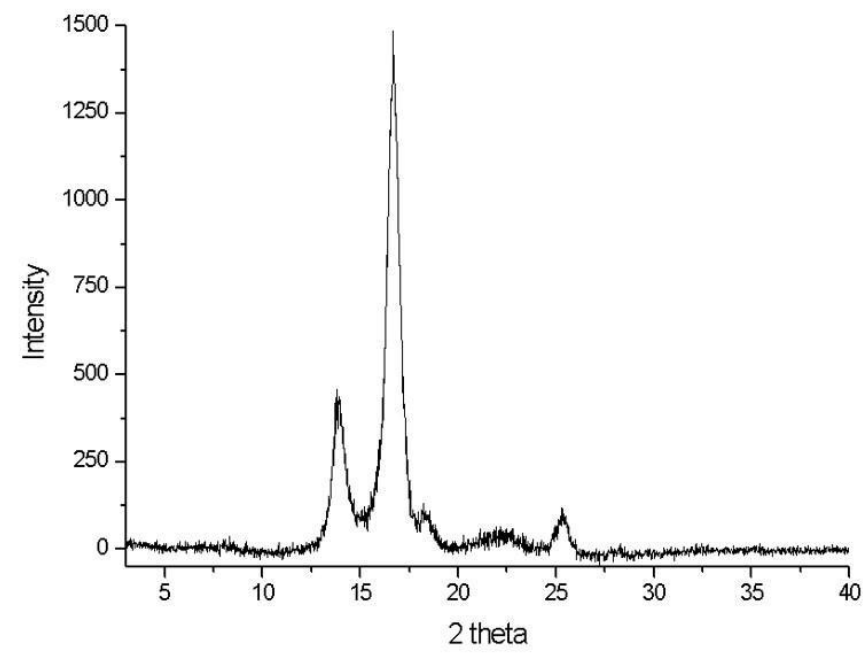
Figure 4. XRD pattern of Catalpa bignonioides fiber.